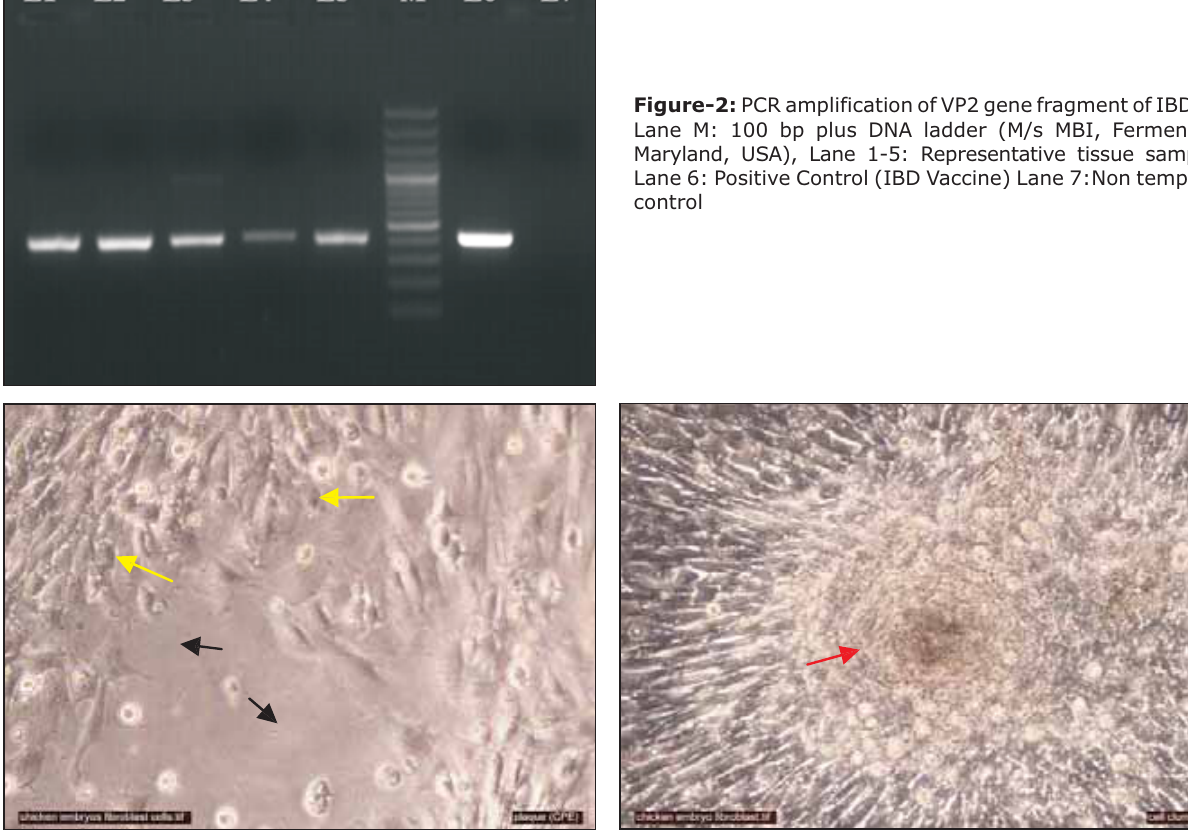
Figure-3: CEF cells showing CPE, 48 hours post inoculation of IBDV on fourth passage indicated by arrows (black-plaque formation, yellow- rounding of cells, and red-